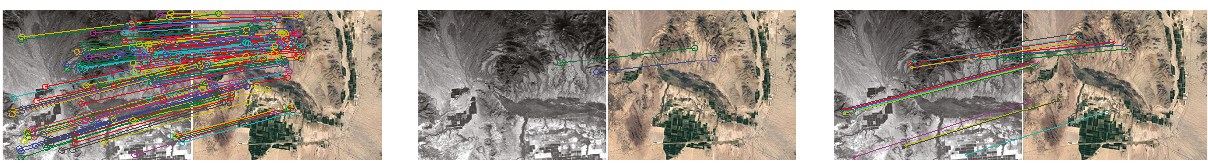
Figure 21: River landmark registration result with SURF, PCA-SURF, and CSA-SURF.